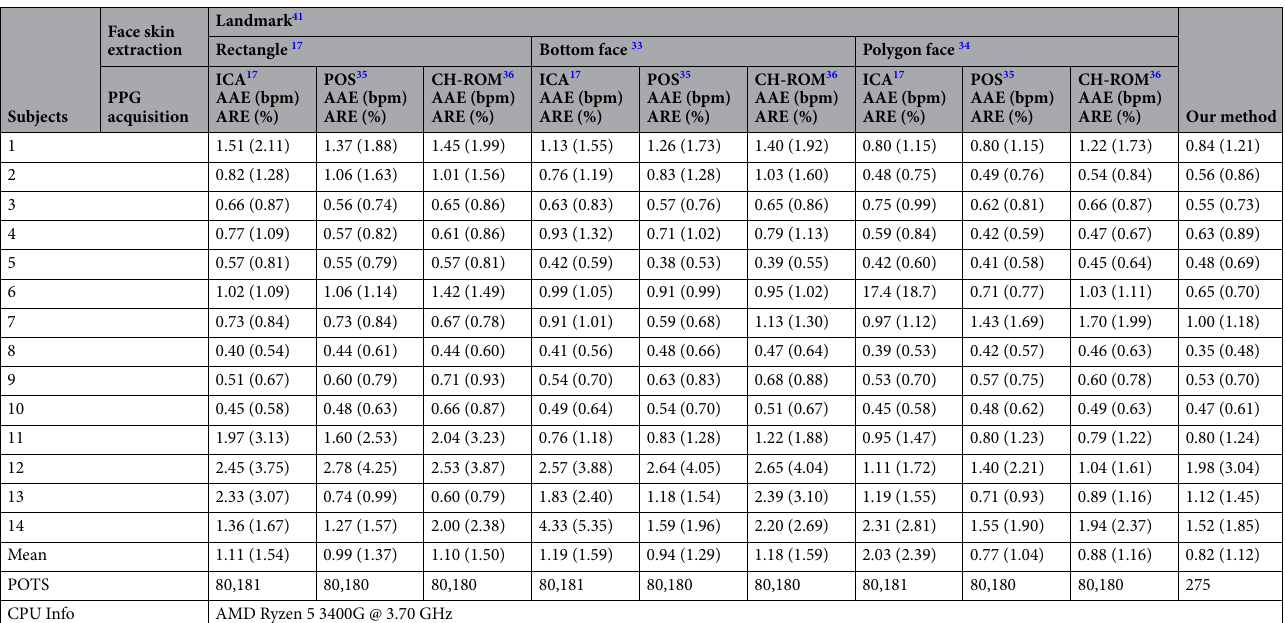
Table 3. Performance comparison of various methods in terms of accuracy (AAE and ARE) and computation time (POTS): independent testing dataset – BAMI-RPPG (n =